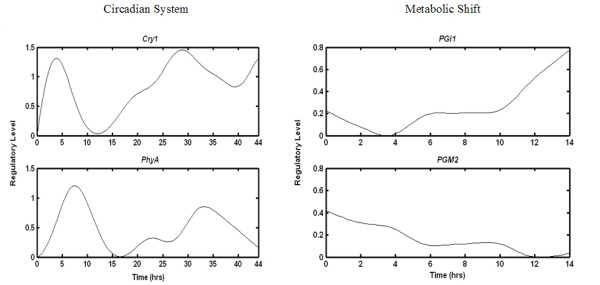
The extracted upstream regulatory functions of pathway genes. The upstream regulatory function  extracted from expression profiles of corresponding target genes Cry1, PhyA (pathway of circadian regulatory system of Arabidopsis thaliana) on the left-hand side, and PGI1, PGM2 (metabolic shift pathway of yeast Saccharomyces cerevisiae) on the right-hand side.